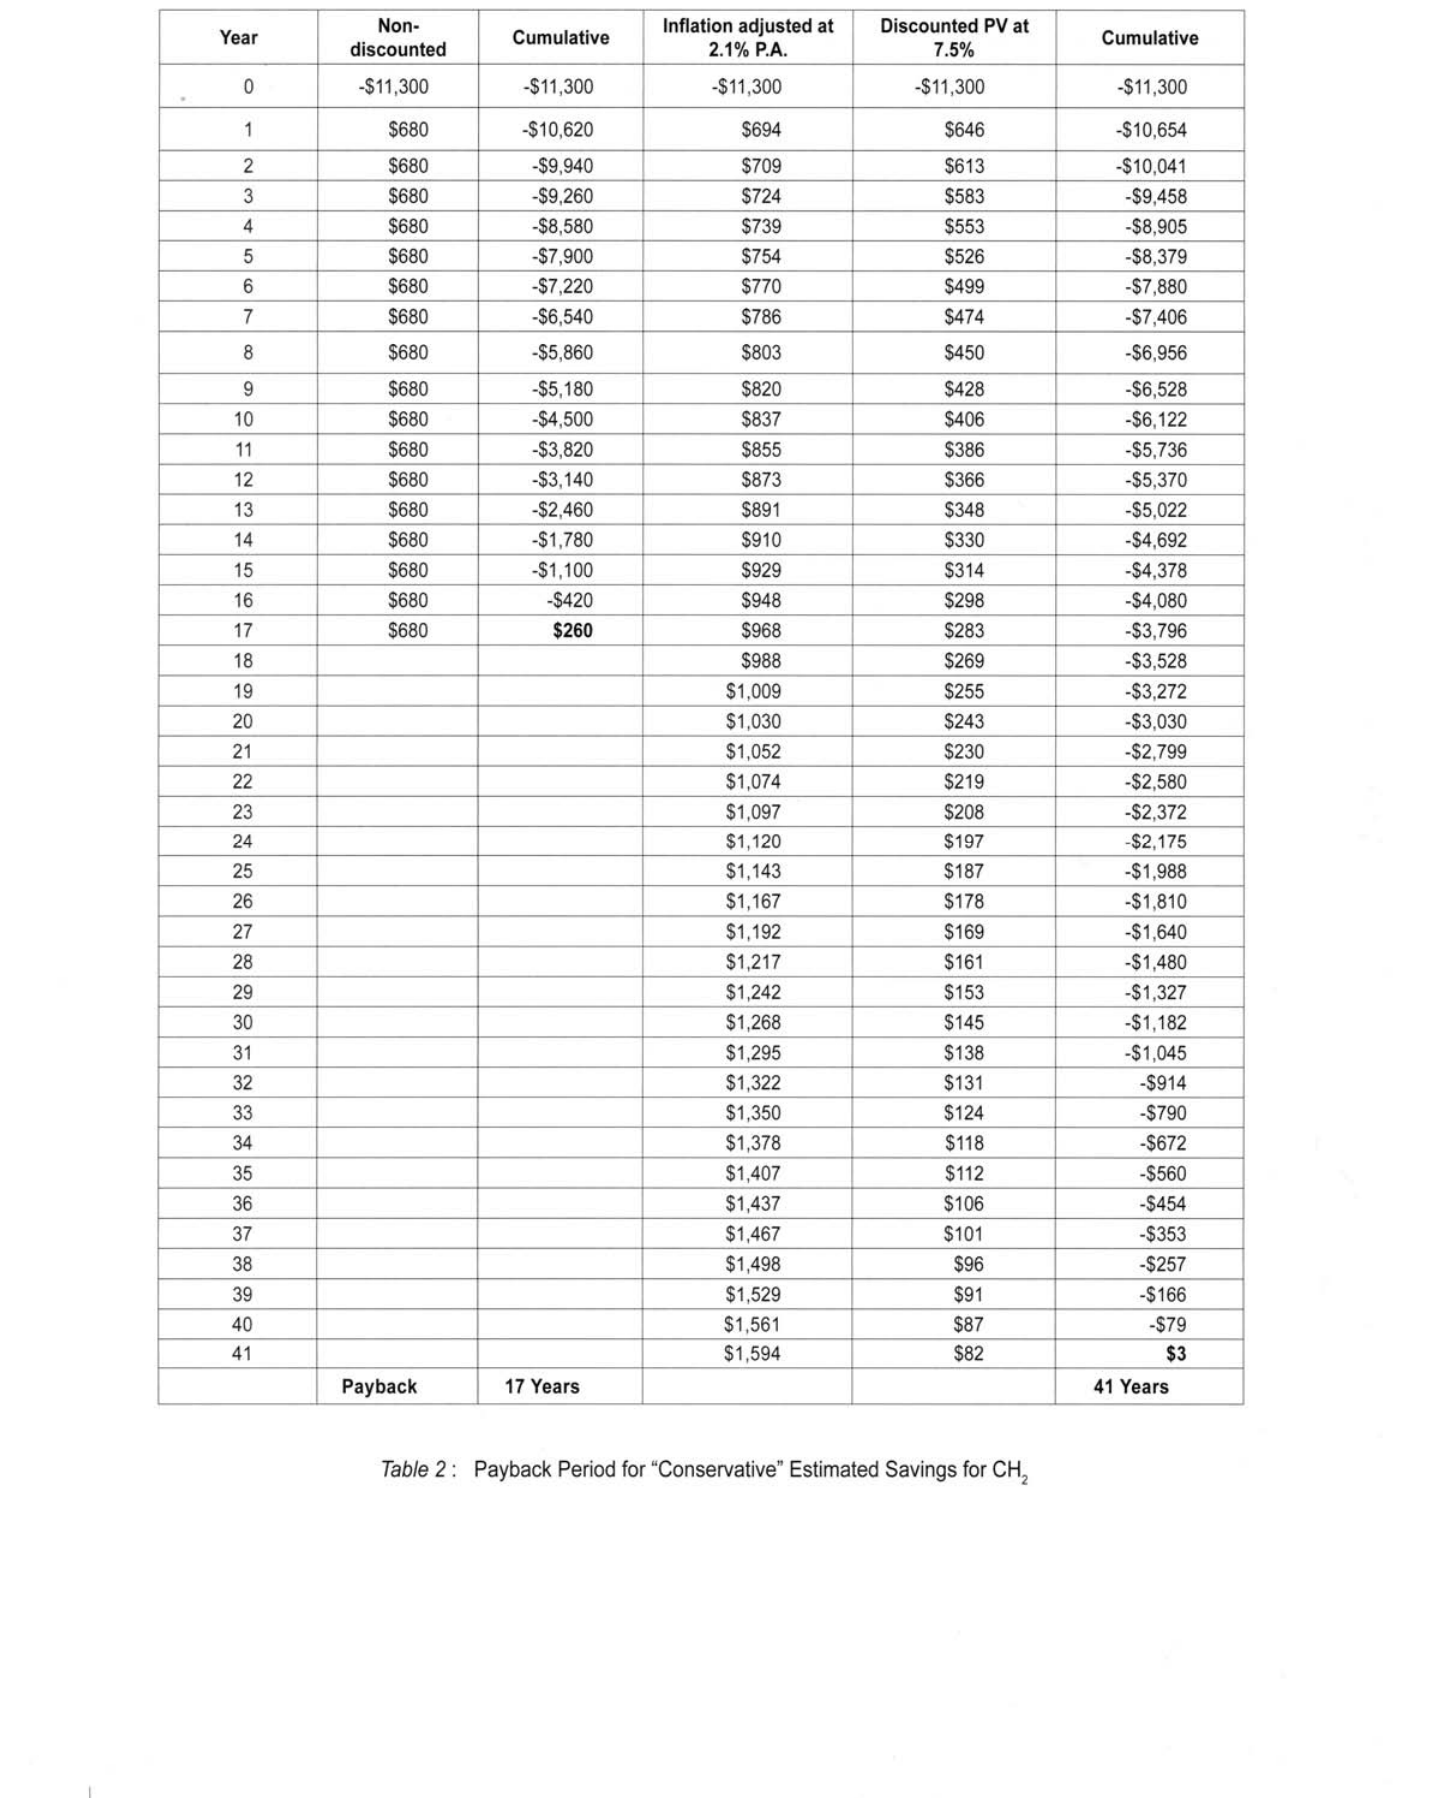
Table 2: Payback Period for "Conservative" Estimated Savings for CH